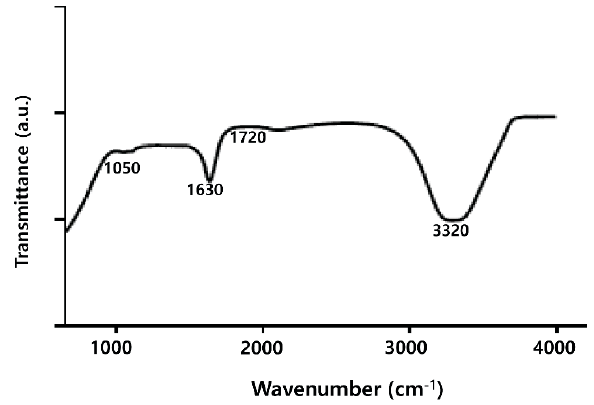
Figure 3. Fourier transform infrared spectroscopy (FTIR) spectra of dried palladium nanoparticles (PdNPs).